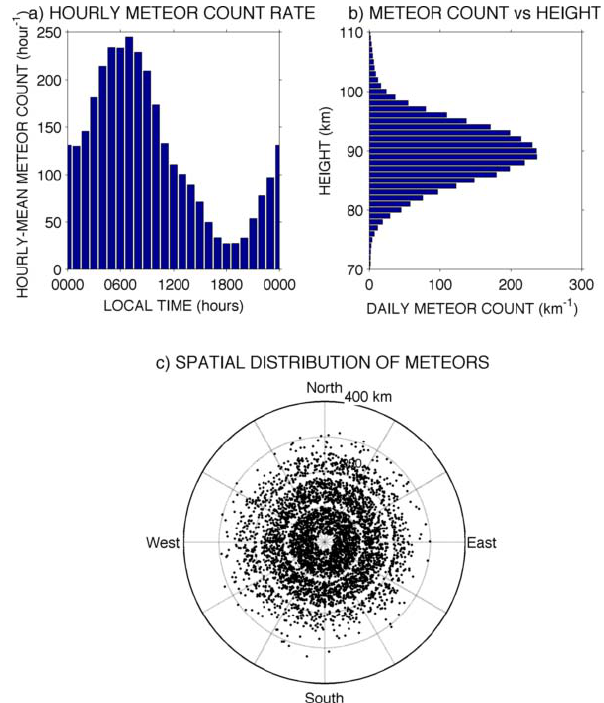
Fig. 1. (a) The diurnal cycle of meteor counts detected by the As- cension Island meteor radar (calculated from the ∼ 200000 meteors detected in 2005). (b) The vertical profile of these meteor counts as a function of height, presented as meteor counts per km. (c) The distribution of meteors detected on 22 July 2005 projected onto a horizontal plane.